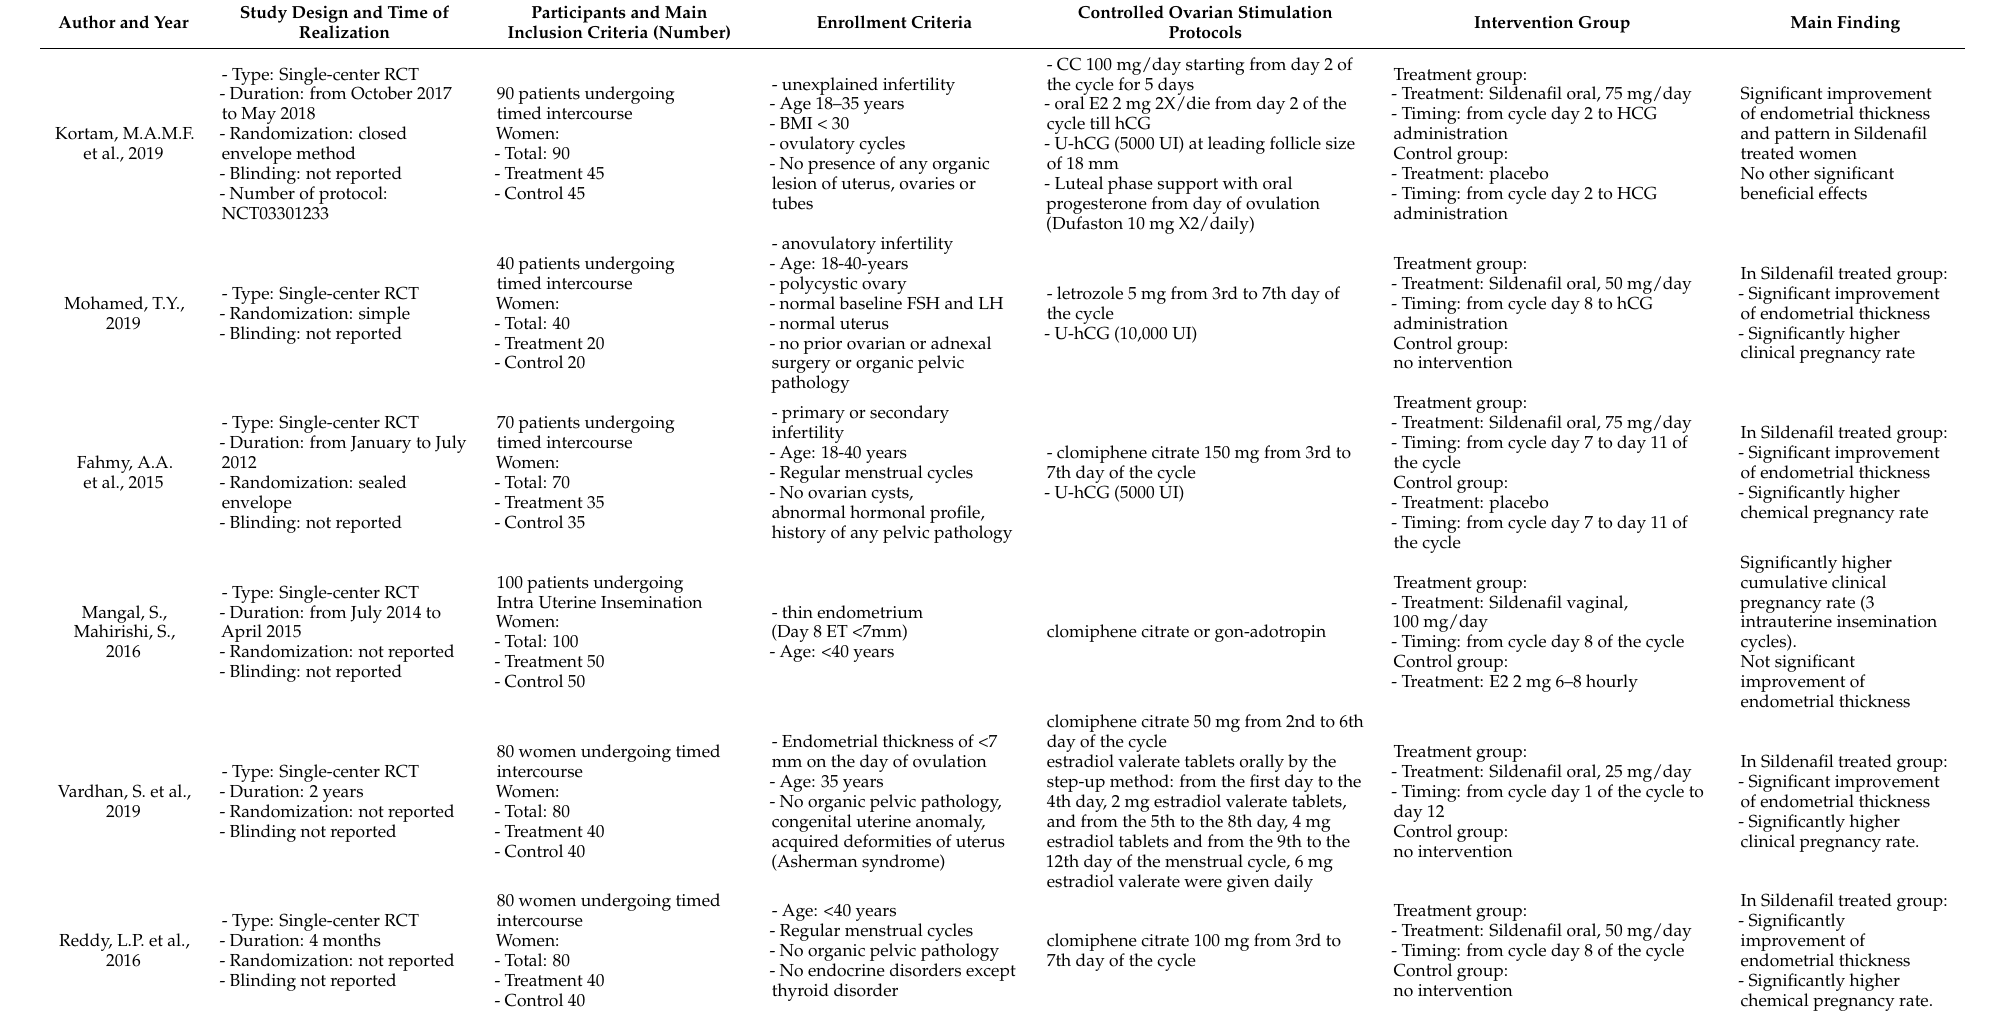
Table 1. Data about general features of the manuscripts evaluated in this systematic review and meta-analysis including the dose and the days of Sildenafil treatment in intrauterine insemination cycles/timed intercourse